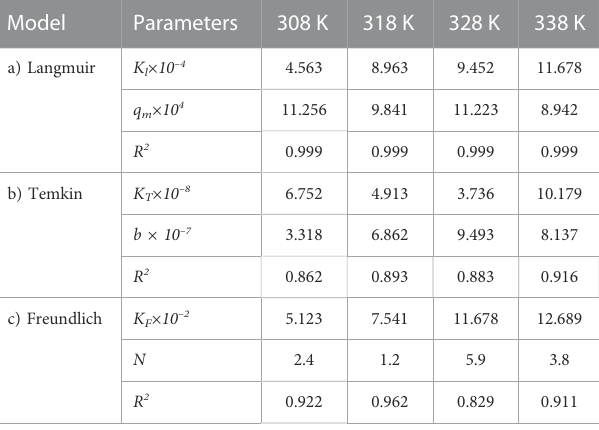
TABLE 5 Parameters of a) Langmuir, b) Temkin, and c) Freundlich isotherm models at different temperatures using Oil sludge 2 as caron active at pH = 5 and adsorbent concentration of 100 mg/L.